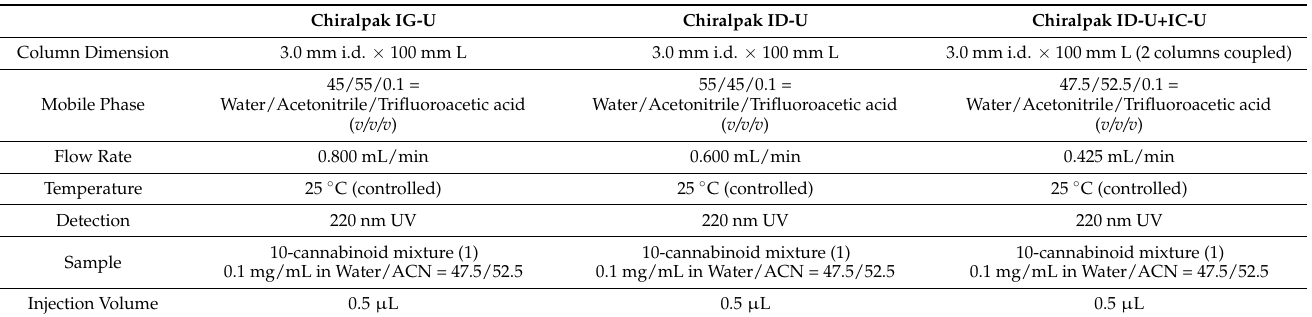
Table 2. Summary of reversed-phase analysis conditions.